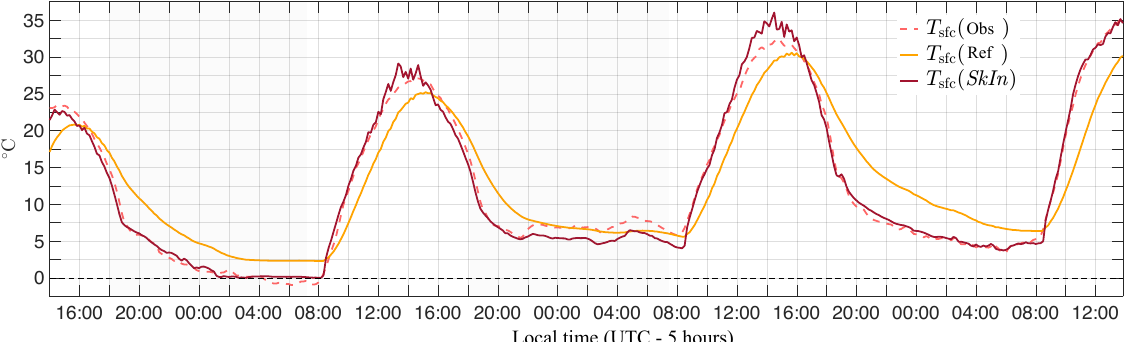
Figure 3. Performance of the JSBACH scheme on diurnal timescales: comparison of time series of the surface temperature ( T sfc ) between the reference model (orange line) and SkIn (red line) plotted against observations (dashed line). Data are from the CASES-99 experiment in Kansas from 23 to 26 October